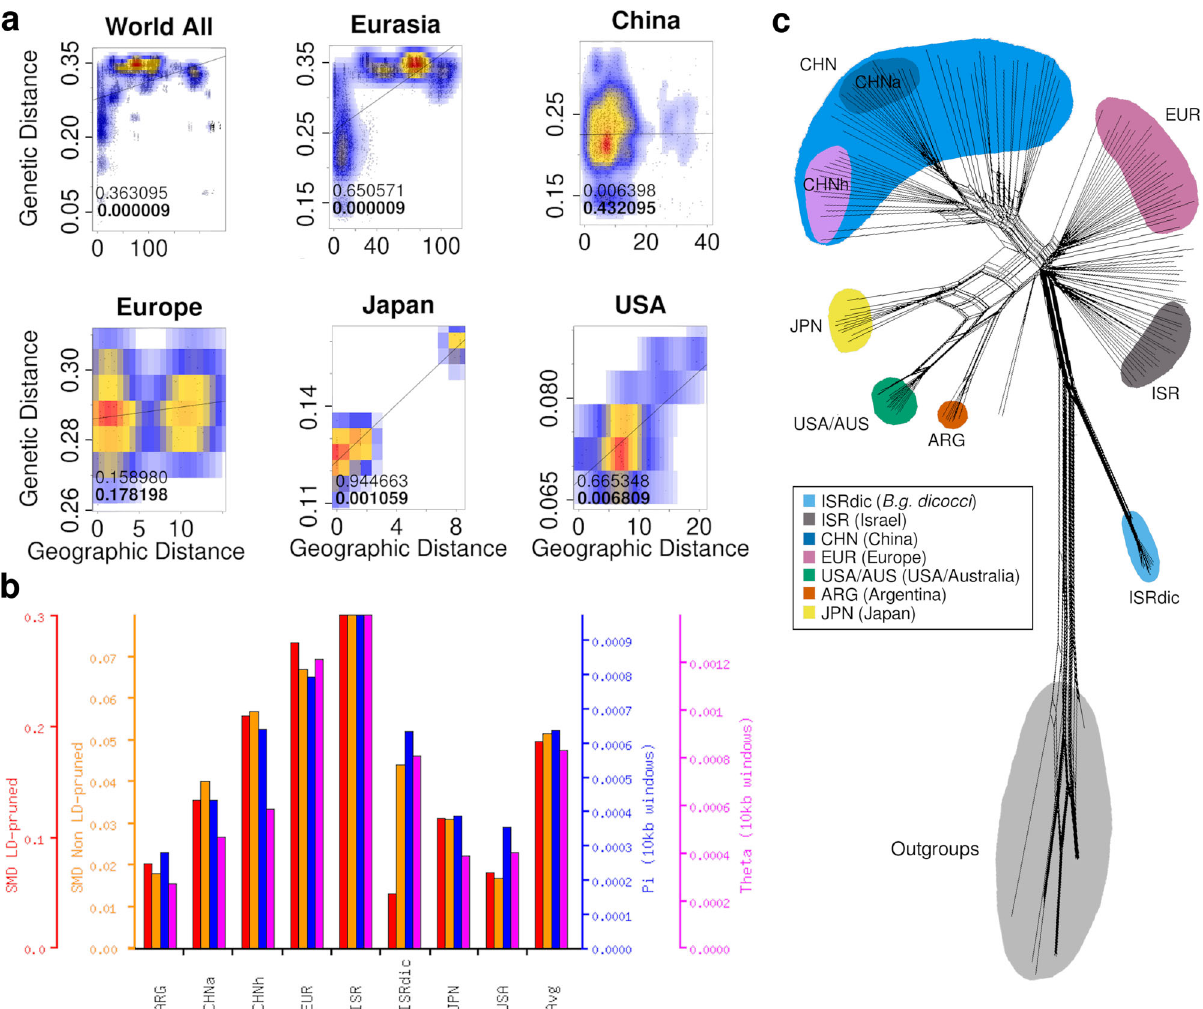
Fig. 2 Population analyses of the wheat mildew populations. a Correlation of the Geographic Distance (tens of kilometers by coordinates of the isolates) with the Genetic Distance (Simple Mismatch) using Kernel Density Estimation. In each plot, the Mantel test correlation and its p value (in bold) are shown. b Average differences within populations (ADW) diversity with simple mismatch LD-pruned SNPs (red bars), ADW diversity with simple mismatch un fi ltered SNPs (orange bars), π genome-wide (average of 10 kb windows, blue bars), and Watterson ’ s Theta genome-wide (average of 10 kb windows, pink bars). Note that B.g. dicocci shows low relative values of simple mismatch distances for LD-pruned SNPs, which could indicate the presence of multiple distinct lineages (see Supplementary Fig. 9 for details). c Phylogenetic network constructed with NeighborNet (SplitsTree software) using simple mismatch distances and a set of 2994 SNPs. The different main groups are colored. The isolates that are not colored belong to mildew populations of Turkey, Russia, Kazakhstan, and some isolates from Israel and China that do not cluster with the main groups (additional networks using different SNP datasets are shown in Supplementary Figs. 10 and